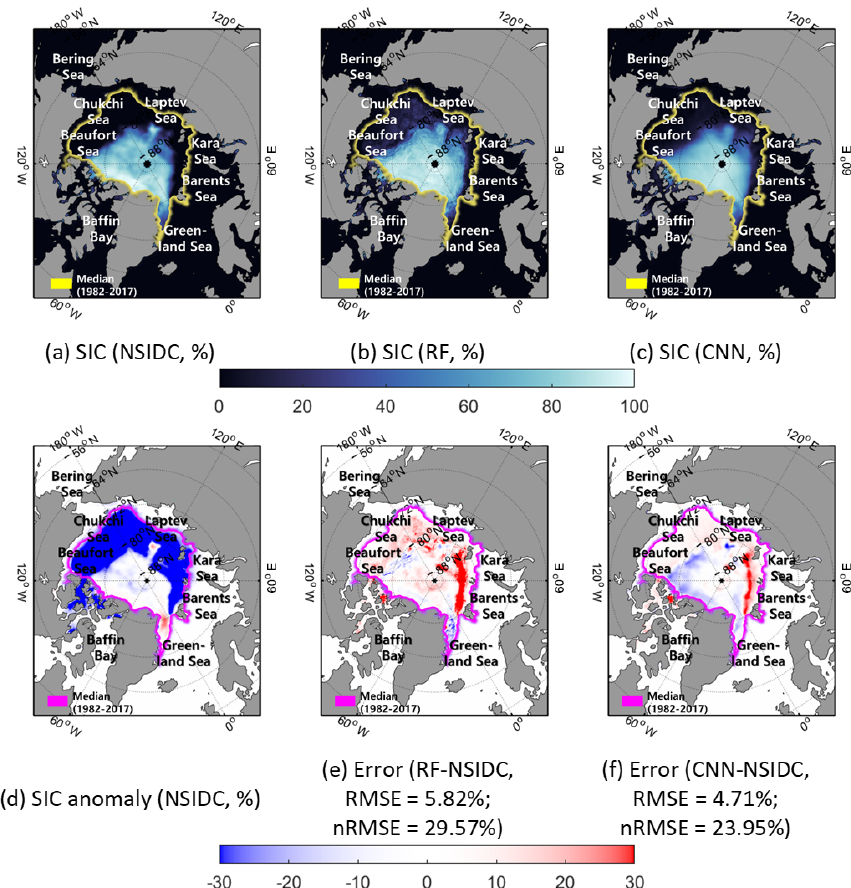
Figure 9. The actual SIC (a) , predicted SICs (b–c) , SIC anomaly (d) , and errors between predicted and the actual SICs (e–f) in Septem- ber 2012. Table 3. The average relative variable importance for the RF and CNN models in September (2000–2017 average, 2007, and 2012). The highest value is highlighted in